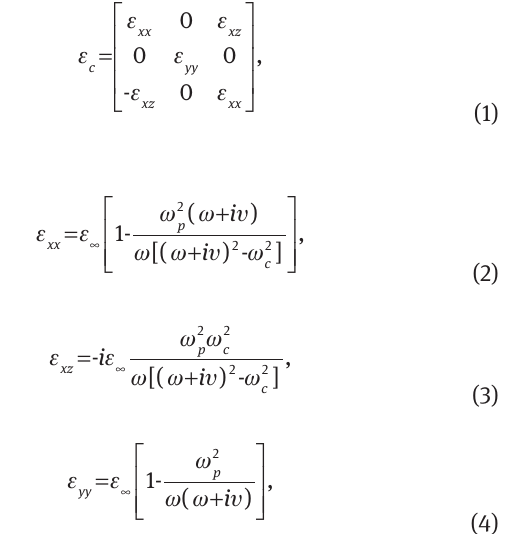
Figure 1: Surface Magneto Plasmons propagating on a conductor surface. (A) Faraday geometry. (B) Voigt geometry. (C) Perpendicular